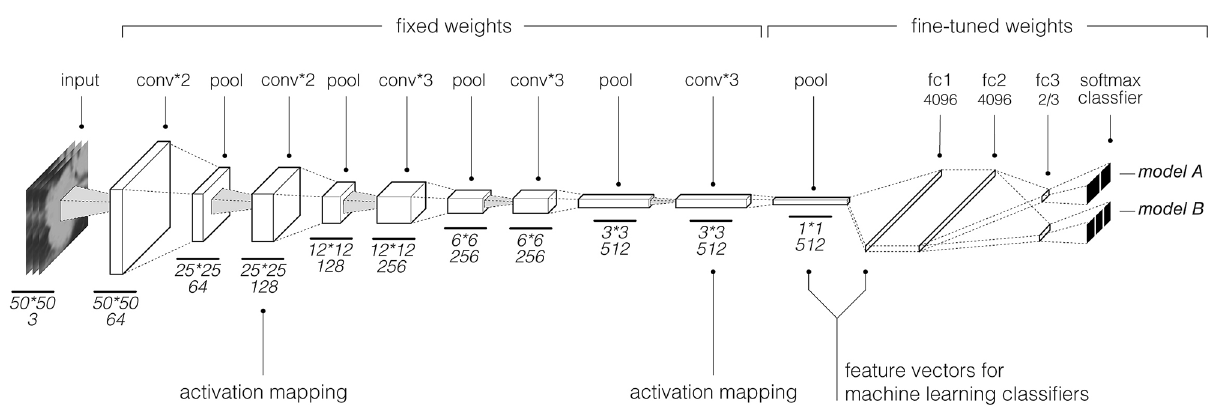
Figure 3. Model A and B schematic; This convolutional neural network architecture is based on the VGG architecture. With our transfer learning approach, weights of the last convolutional and pooling layers were fine-tuned using radiographic data. Model A, tuned on adenocarcinoma and squamous cell carcinoma tuning- set, had two classes as output in the softmax layer, while Model B which was tuned on a dataset containing all histology types had 3 type